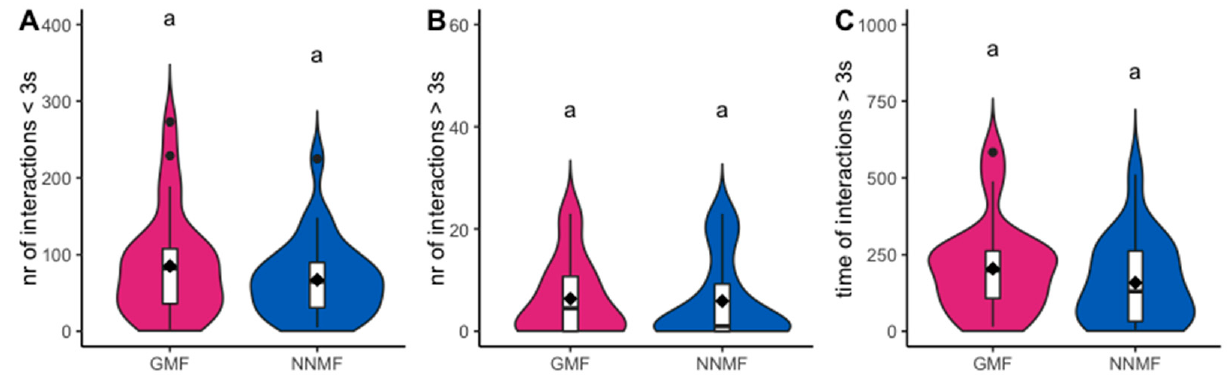
Figure 3. Interaction events of Lasius niger under GMF and NNMF recorded during Phase 2. Violin plots show ( A ) the number of interactions lasting less than 3 seconds between two workers, ( B ) the number of interactions lasting more than 3 seconds between two workers, and ( C ) the time of interactions lasting more than 3 s between two workers. The violin shape shows the distribution of the values, and the box plot inside is made by a black line in the center that indicates the median; the top and bottom of the black box represent the upper and lower quartiles; whiskers represent the maximum and minimum values, while the black dots indicate the outliers. Diamonds indicate mean values. Different letters indicate significantly ( p < 0.05) different values based on generalized linear mixed model results.